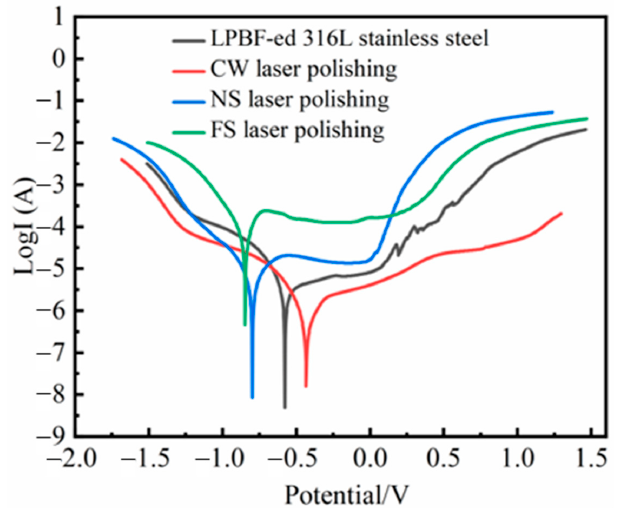
Figure 9. Potentiodynamic polarization curves of original and laser-polished samples. Table 4. Quantitative information of four samples from the potentiodynamic polarization curves.